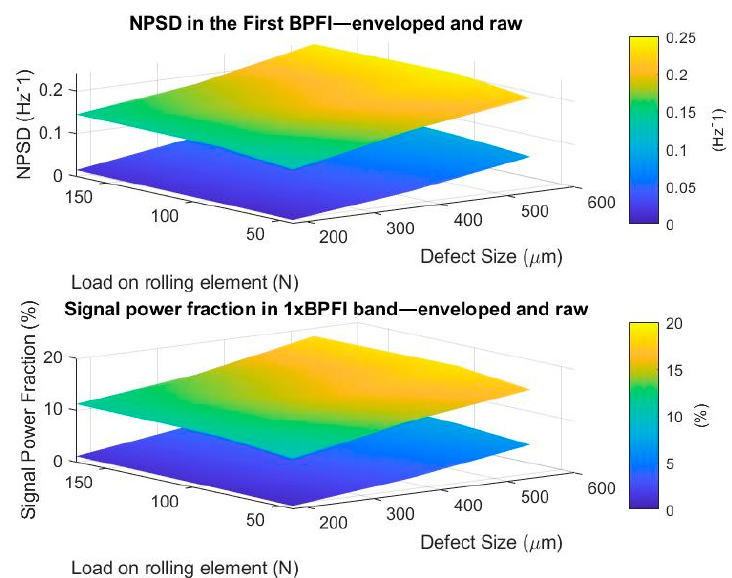
Figure 18. NPSD and health indicator (HI) for the enveloped and nonenveloped pressure signal.